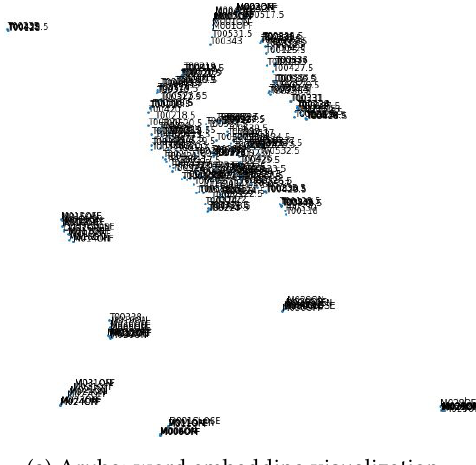
Figure 5. Aruba: Word2Vec embedding.